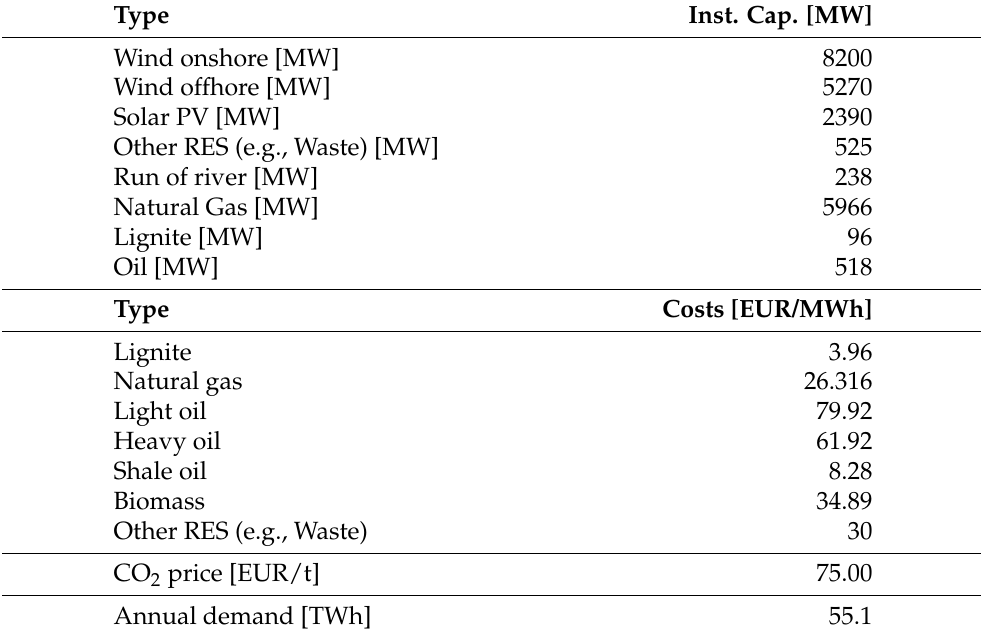
Table 2. Installed Capacities, commodity and emission costs as well as total energy demands